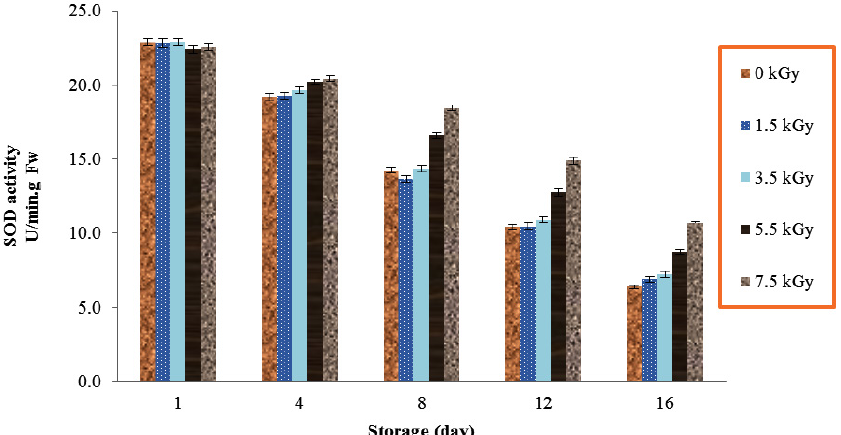
Fig. 2. Effect of Electron-Beam Irradiation on SOD Activity in Agaricus Brunnescens Fruit Bodies During Storage at 4 °C. Vertical Bars Represent the Standard Deviation about the Mean (r =